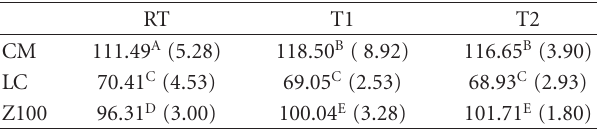
Table 2: Means and SDs values of KHN for the three composite materials. Means with same superscript letter did not significantly di ff er statistically ( P > 0 . 05).